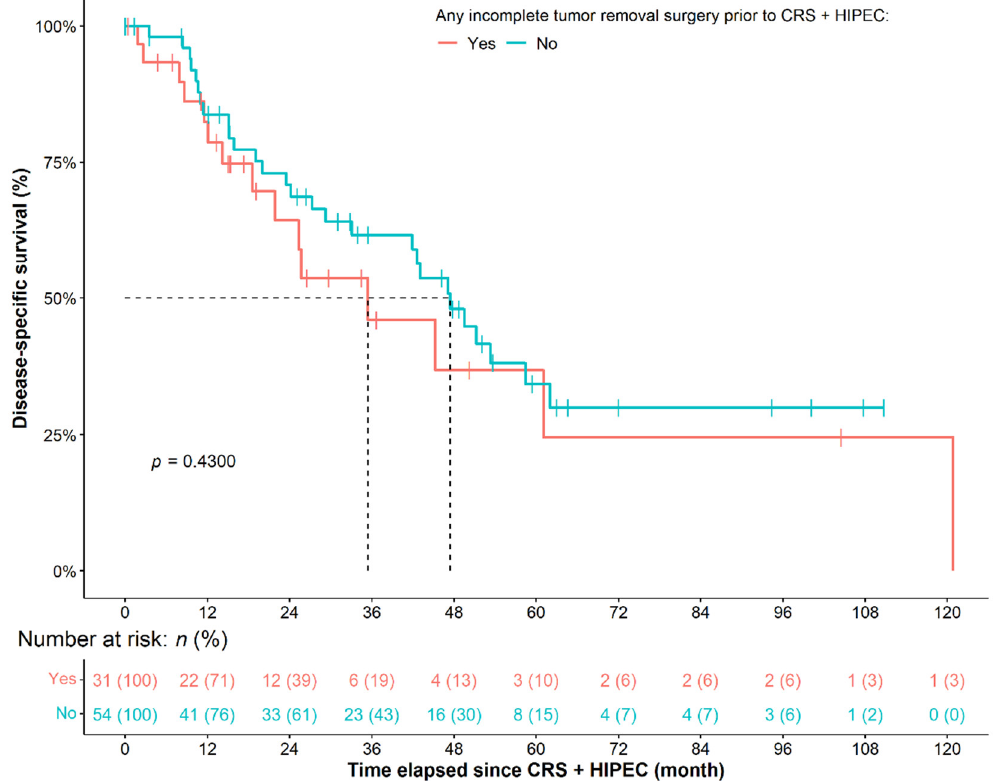
Figure 4. Survival of primary ovarian cancer patients, who had or did not have any previos, incomplete tumor removal surgery prior to the CRS + HIPEC procedure. CRS: cytoreductive surgery; HIPEC: hyperthermic intraperitoneal chemotherapy.